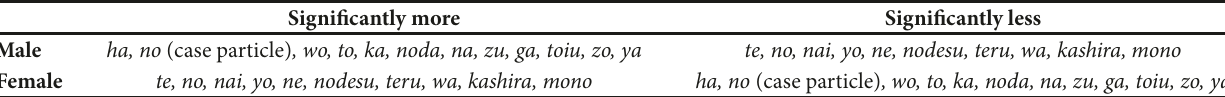
Table 3: Significant words for each gender.